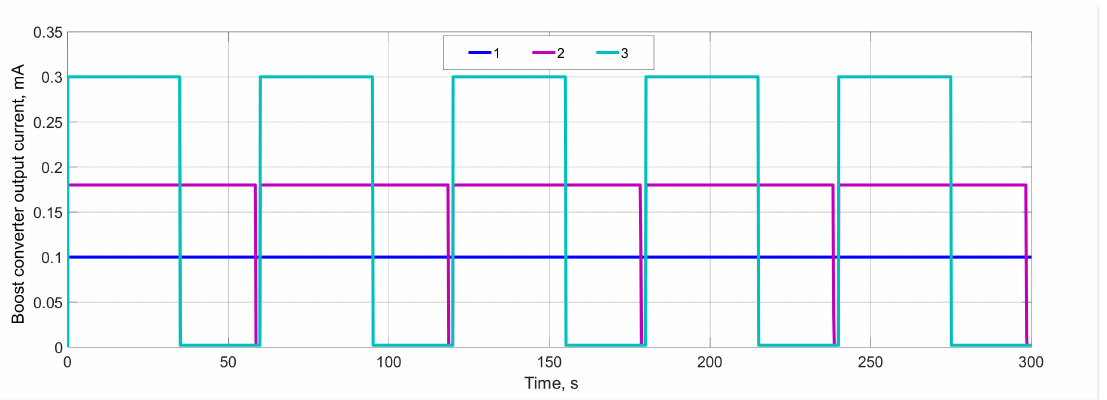
Figure 14. Virtual oscillograms of boost converter output current. Inlet pressures of the vortex tube: 5 bar (1), 6 bar (2), and 7 bar (3).